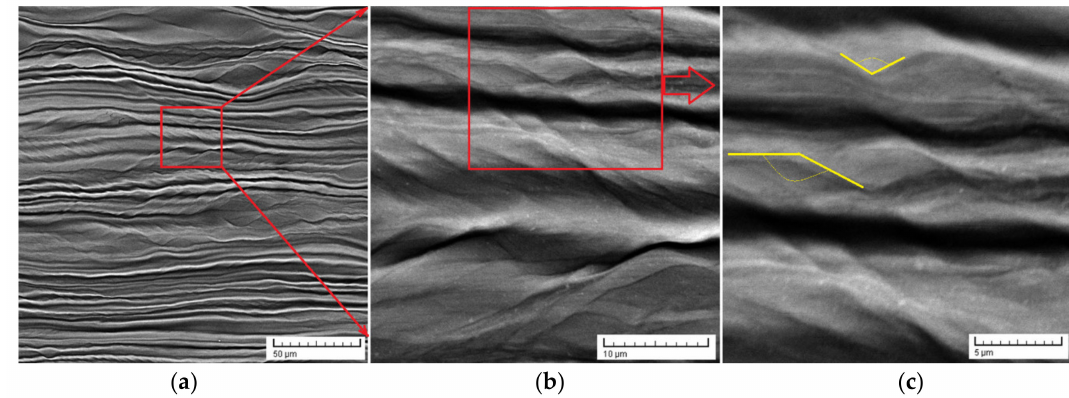
Figure 5. SEM-BSE images of the sample processed by SPD-MPR ( ε tot = 90%); ( a )–( c )—represent the same sample with increasing magnification of the visual field sequences from ( a ) to ( c ); yellow mark—shear bands with large misorientation